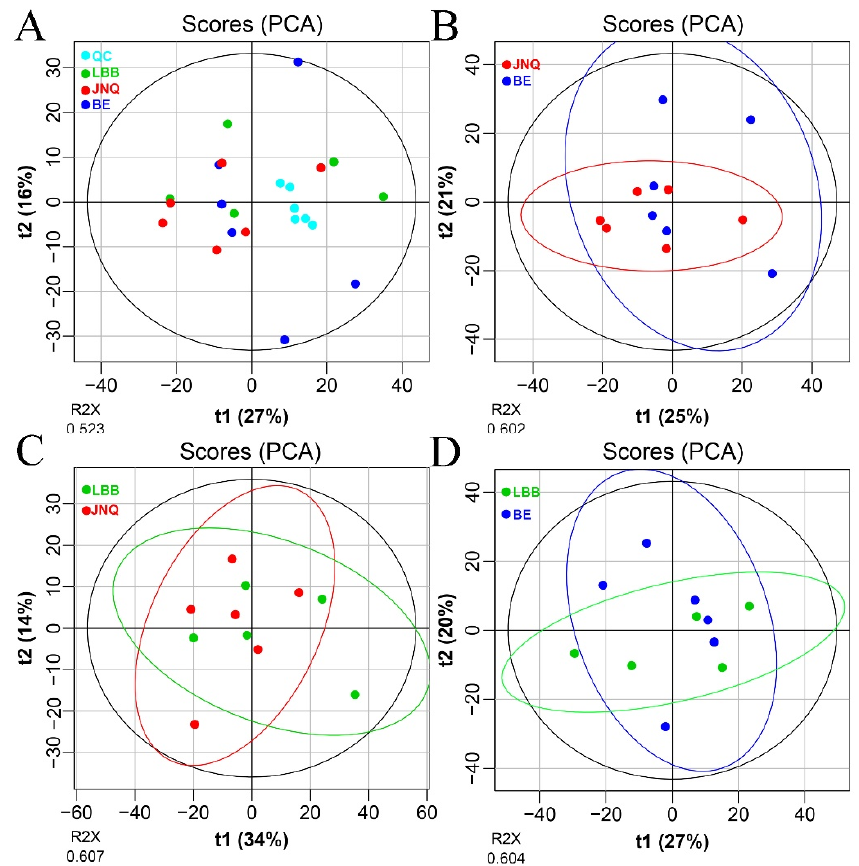
Figure 1. PCA plots showing the different metabolic patterns of goat meat. ( A ) all goat meat samples, ( B ) meat samples from the JNQ group (red) and BE group (blue), ( C ) meat samples from the JNQ group and LBB group (green), ( D ) meat samples from the LBB group and BE group. All with 95% confidence ellipsoids.